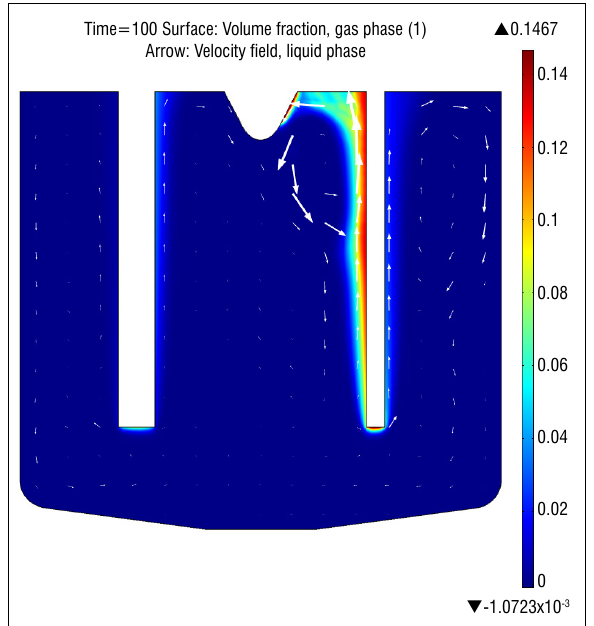
Figure 3: Hydrogen gas phase fraction in the reactor.